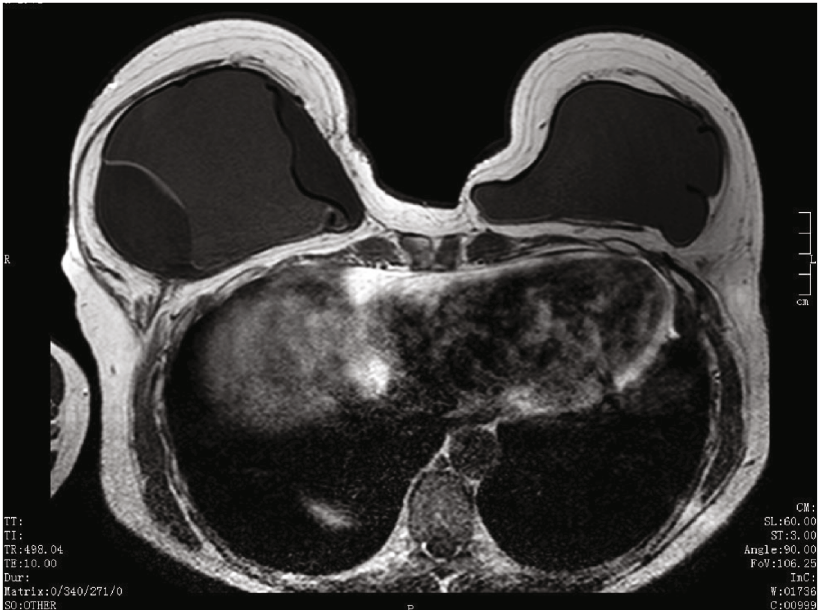
Figure 1: Breast MRI. Smooth circumferential thickening of the right implant fi brous capsule noted with di ff use progressive